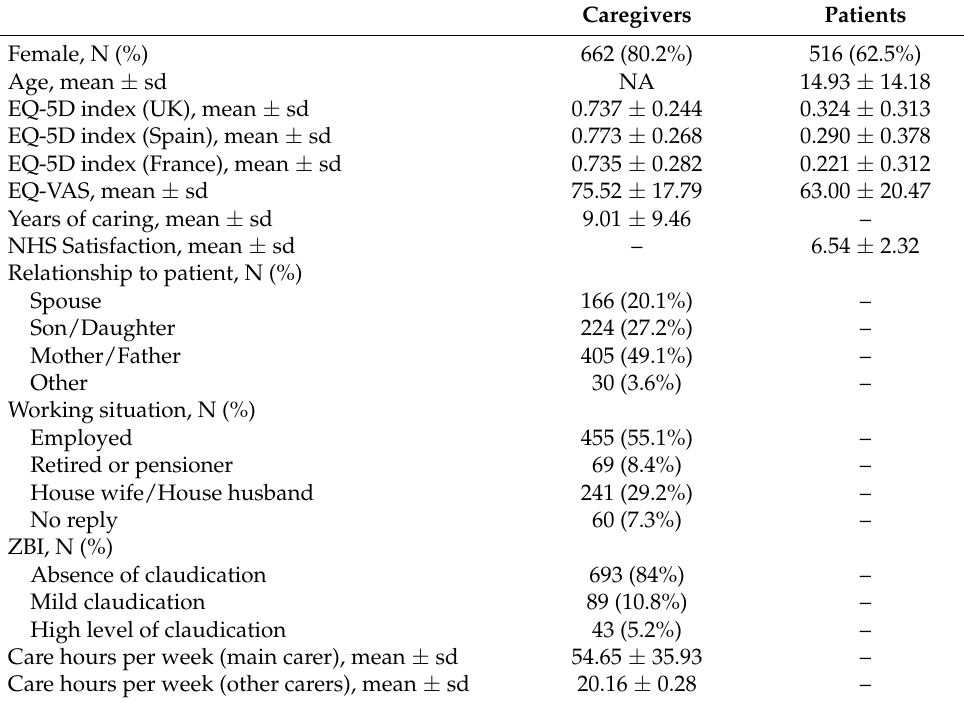
Table 2. Characteristic of caregivers and patients (N = 825).